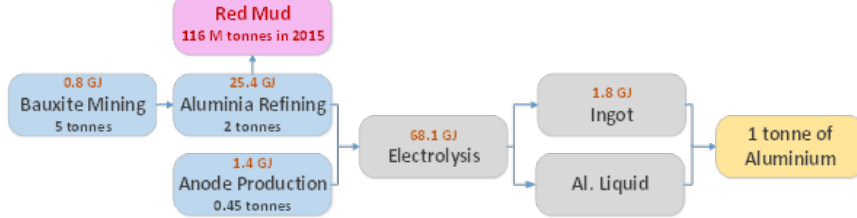
Figure 2. Primary aluminum production steps with associated energy content for producing one ton of material.